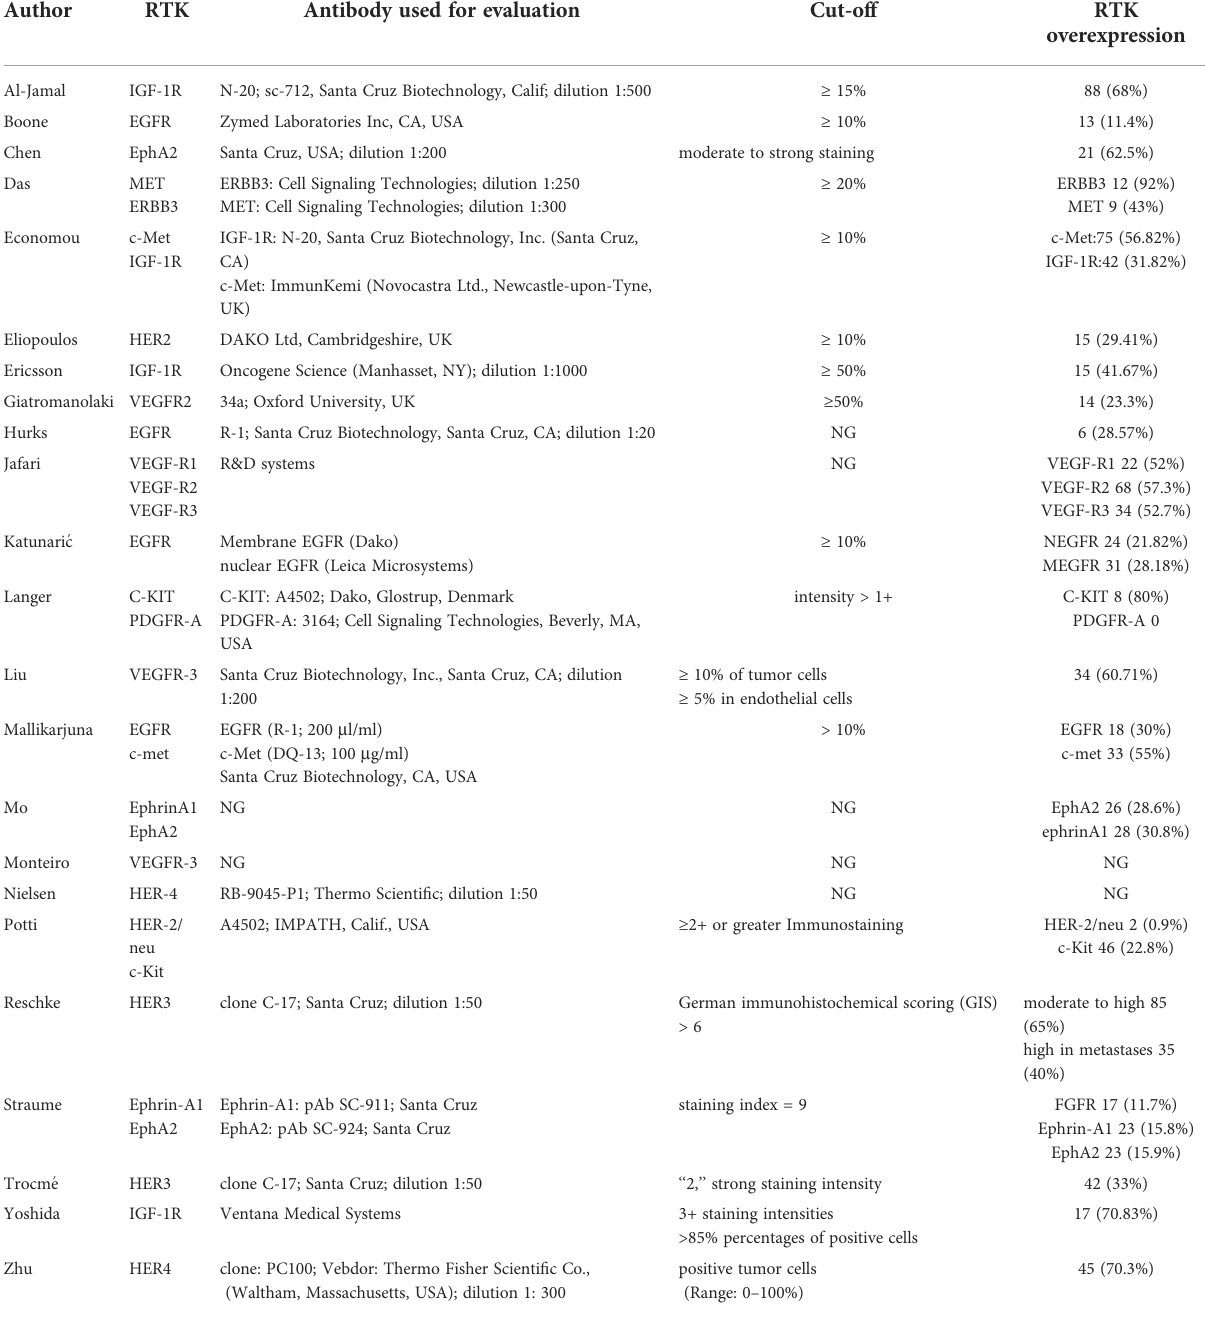
TABLE 2 Expression of RTKs in